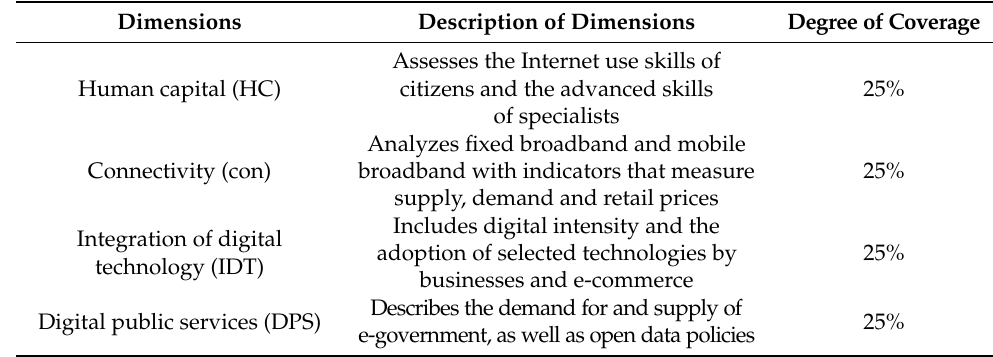
Table 1. DESI description.